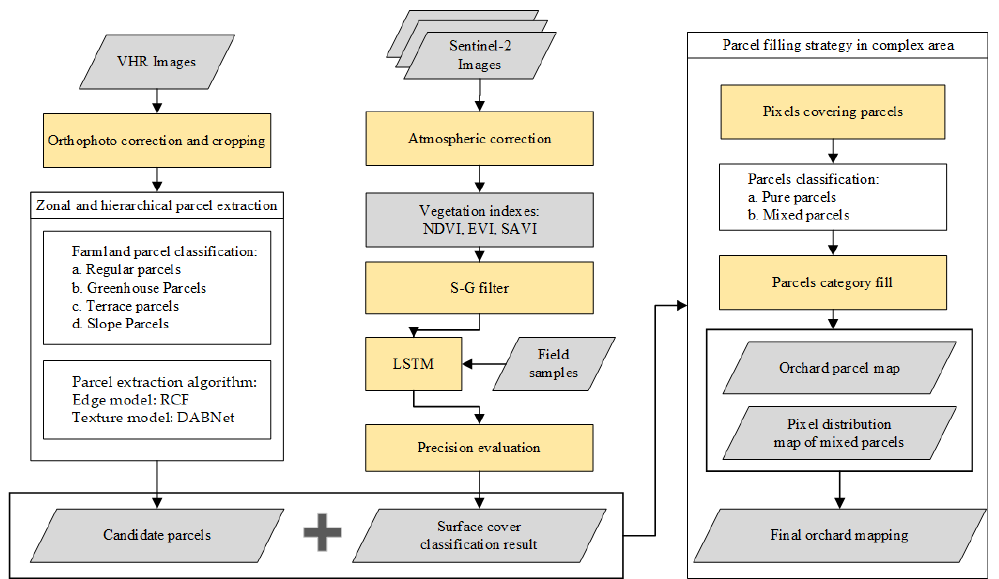
Figure 3. Workflow of the method proposed in this paper.